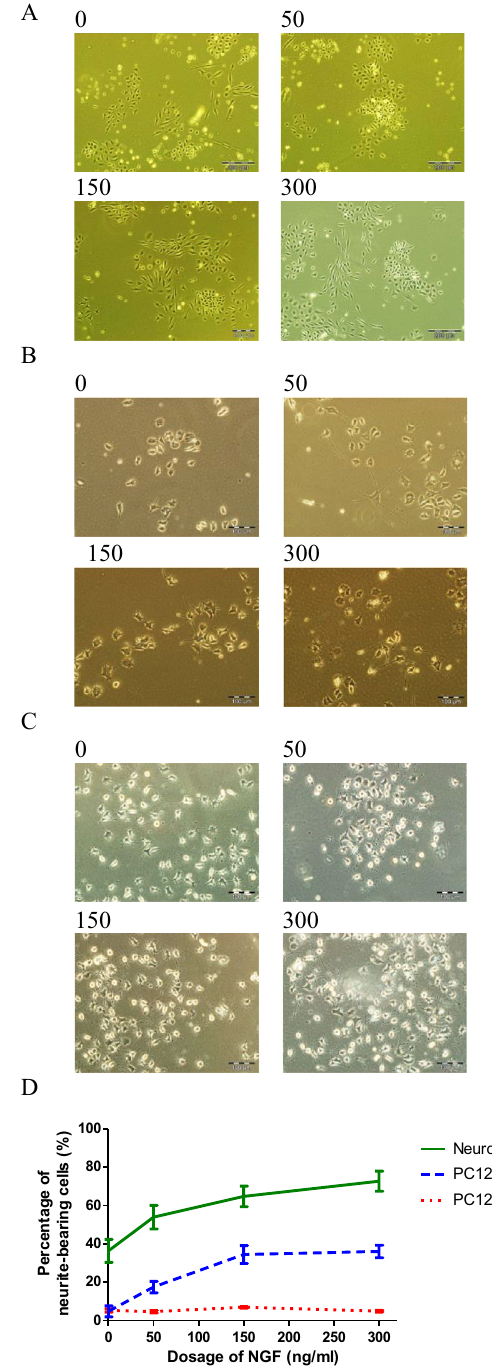
Figure 3. NGF differentiation of 3 PC12 cell variants. PC12 cells were cultured as described in “Materials and methods” and seeded into multiwell plates. After an overnight incubation, the media was changed to one with 2% horse serum (1% for PC12 Adh) and NGF added to the indicated concentration (ng/ml). The media and NGF was refreshed every 48 h and neurite scoring performed at 96 h. ( A ) PC12 Adh cells cultured in Ham’s F-12 K with serum were seeded into a poly-d-lysine-coated 6-well plate at 3 × 10 3 cells/cm 2 . Representative phase contrast images at 100 × magnification were taken 96 h after addition of the indicated concentration of NGF (ng/ml). ( B ) PC12 Riken cells cultured in DMEM with serum were plated onto a 12-well plate coated with collagen IV at a density of 4 × 10 3 cells/cm 2 . Representative phase contrast images at 200X magnification are shown 96 h after addition of NGF at the indicated concentrations (ng/ml). ( C ) NS-1 cells cultured in DMEM with serum were seeded into a collagen-IV coated 12-well plate at a density of 4 × 10 3 cells/cm 2 . Representative phase contrast images (200X magnification) are shown 96 h after addition of NGF at the indicated concentration (ng/ml). ( D ) Three PC12 variants were treated with NGF at the indicated concentrations and the percentage of neurite-bearing cells obtained after 96 h. Data shown is the mean and ± SEM of 3 independent experiments. Scale bar ( A ) 200 µm, ( B , C ) 100